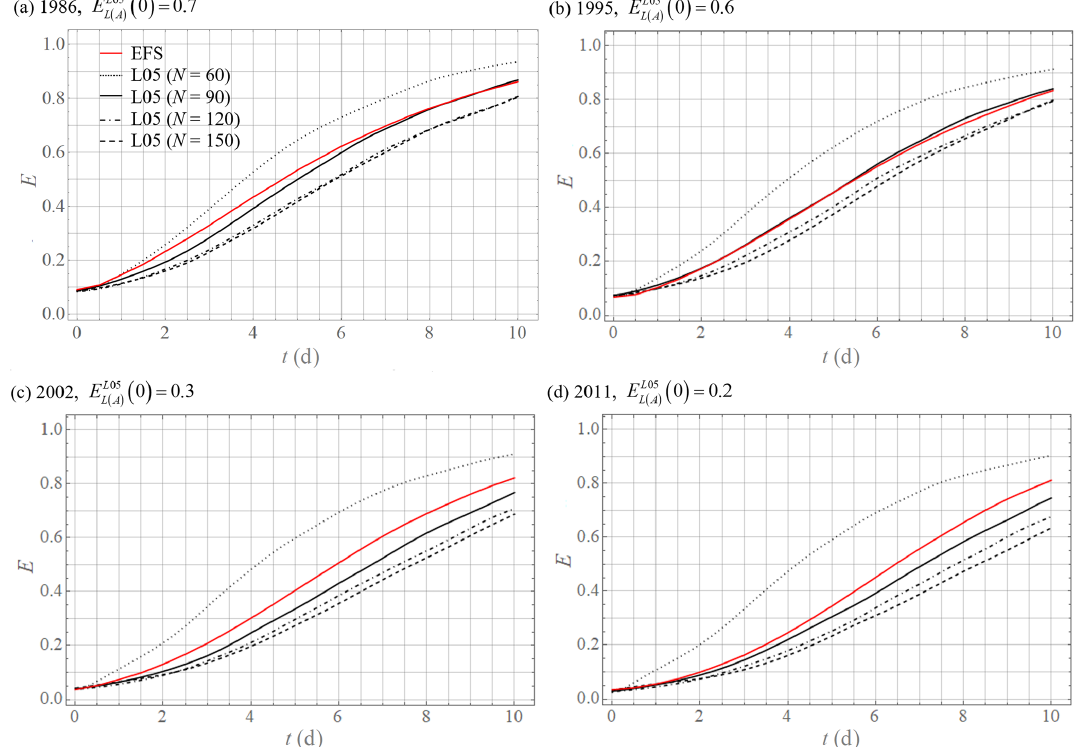
(Eq. 15) ,L (Table 2) (L05; arithmetic ,L